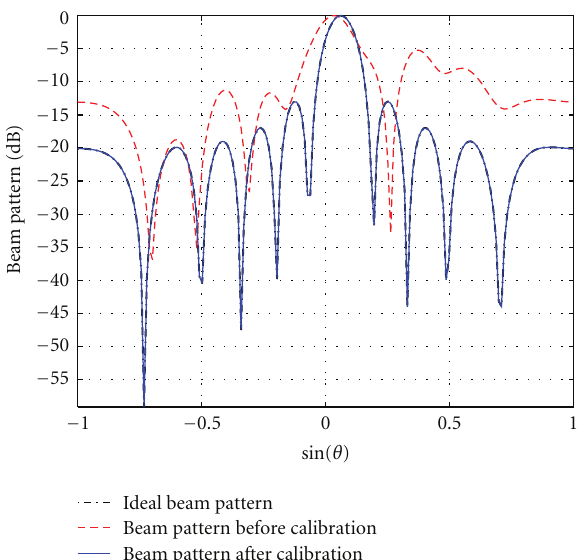
Figure 3: Beam pattern estimates obtained before and after gain/ phase calibration, as compablue to the ideal case.